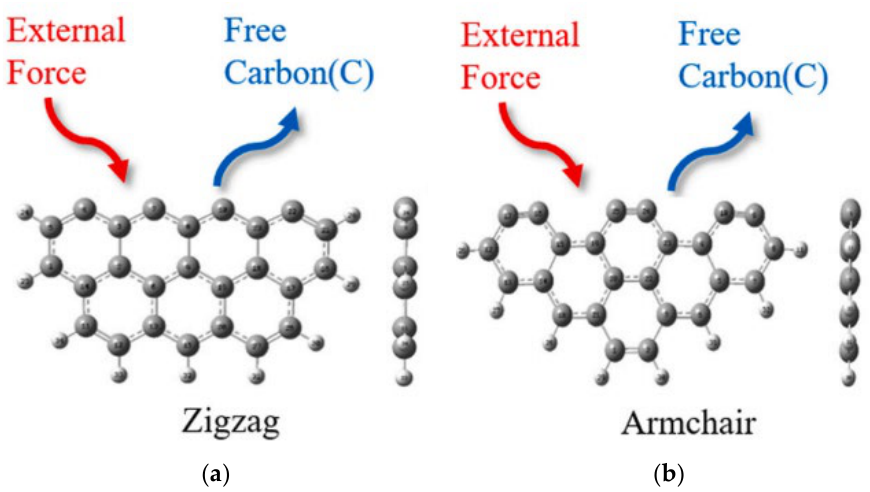
Figure 10. Defective structure caused by external force: ( a ) Zigzag model and ( b ) Armchair model [71]. Reprinted/adapted with permission from Ref. [71]. 2022, Journal of Hazardous Materials.